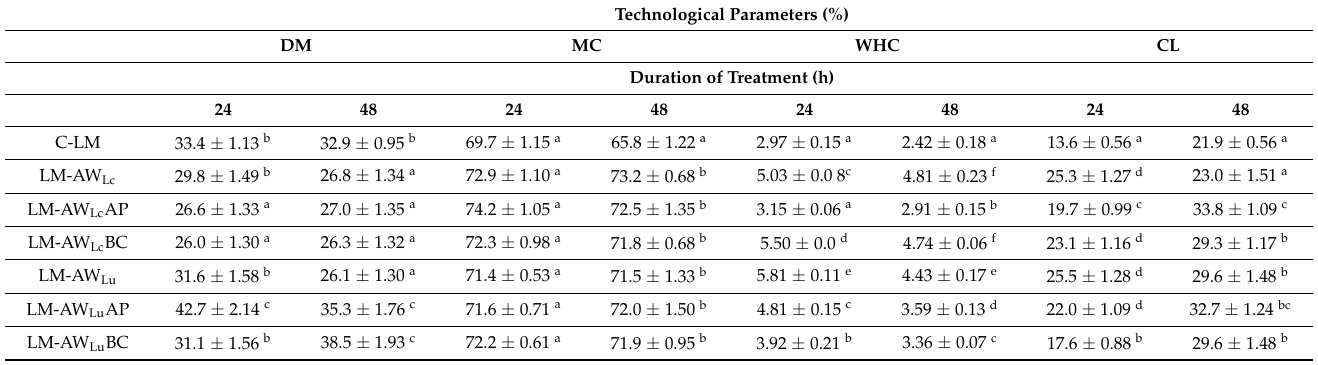
Table 6. The technological parameters of the lamb meat samples treated with the different marinades. Technological Parameters (%) MC WHC CL Duration of Treatment